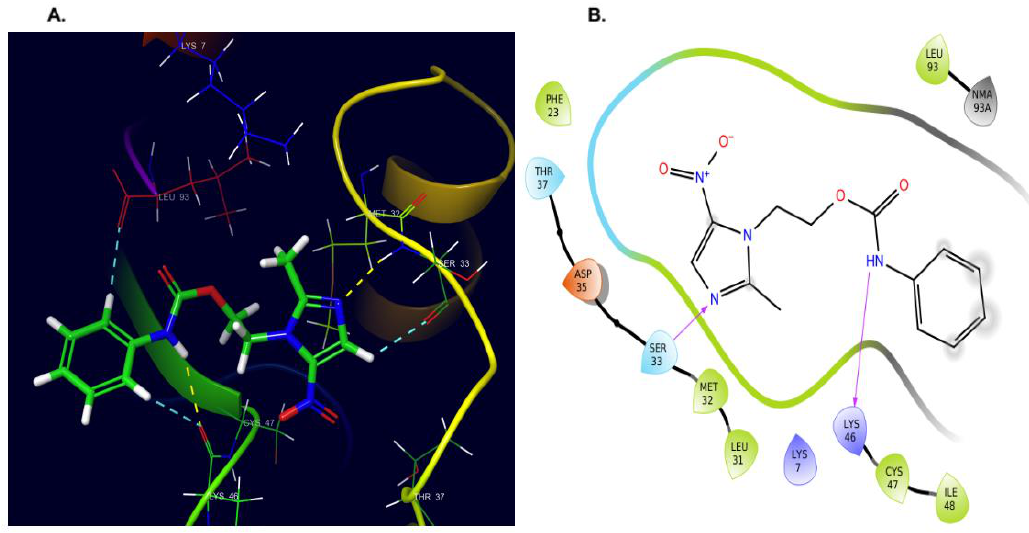
Figure 5. ( A ) 3D and ( B ) 2D representations of the binding model of compound 2 in the proposed site for metronidazole in PFOR.